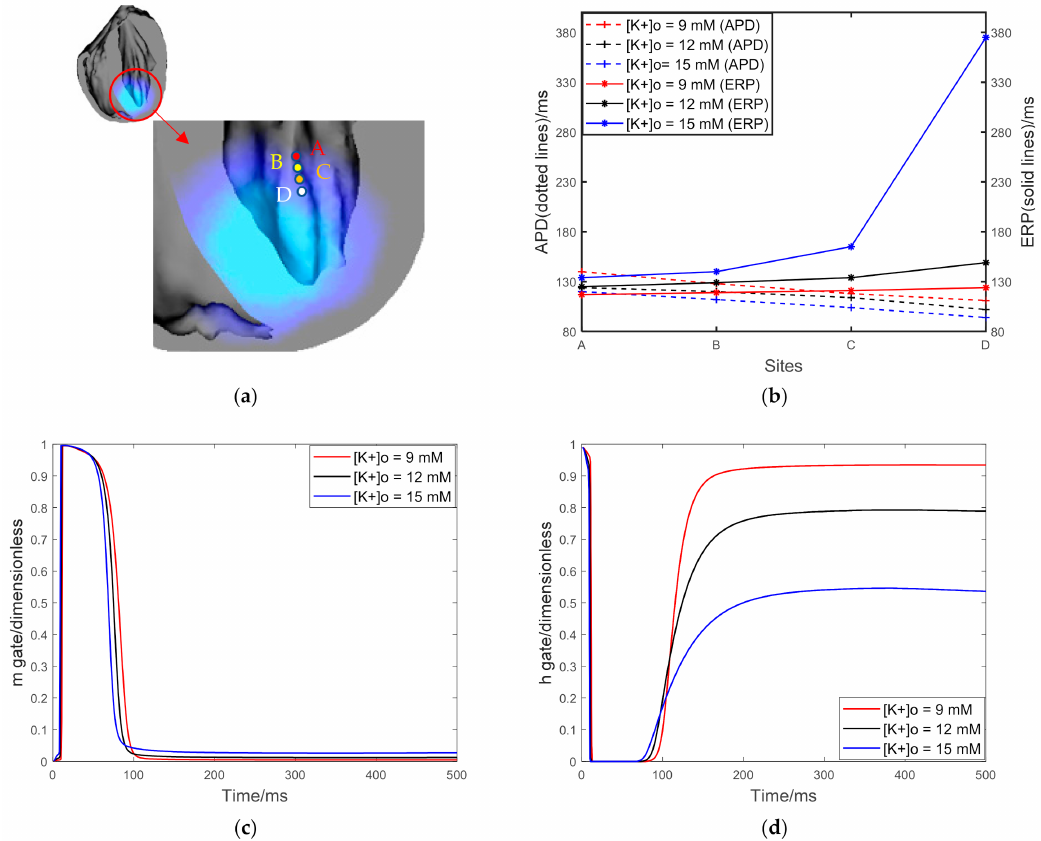
Figure 8. ( a ) The measurement sites of effective refractory period and action potential duration; ( b ) Effective refractory period and action potential duration of ABCD at different extracellular potassium concentrations; ( c ) Activation gates (m gate) of I Na of D under different extracellular potassium concentration; ( d ) Fast inactivation gates (h gate) of I Na of D under different extracellular potassium concentration (0 time is the time when the action potential